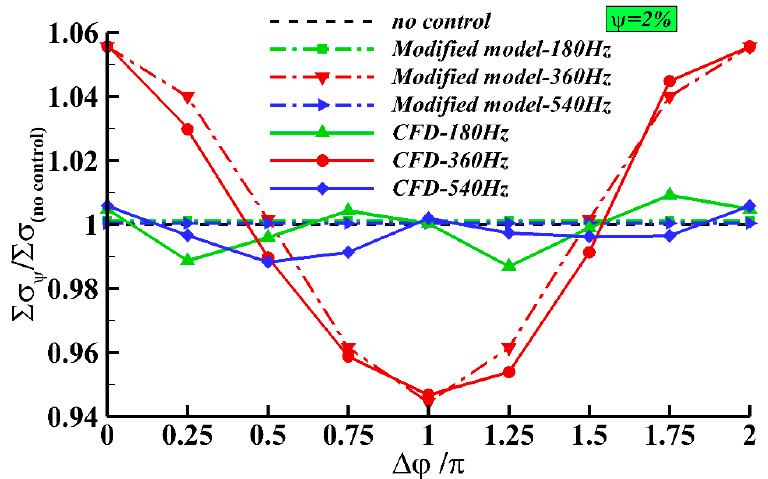
Figure 19. Control effects of modified model and CFD simulation under different frequencies.